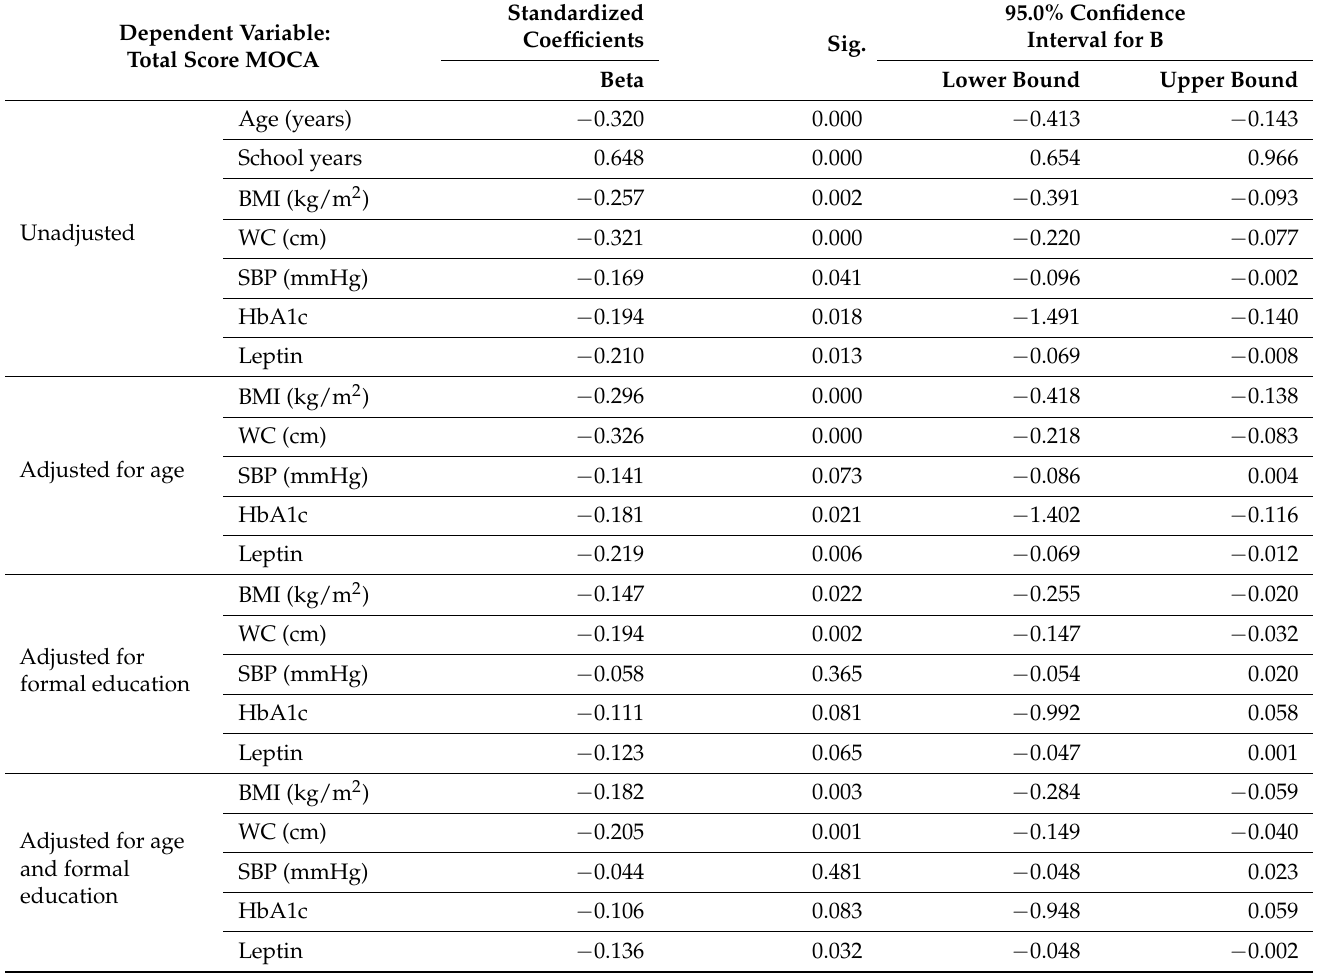
Table 9. Predictors of the MoCA total